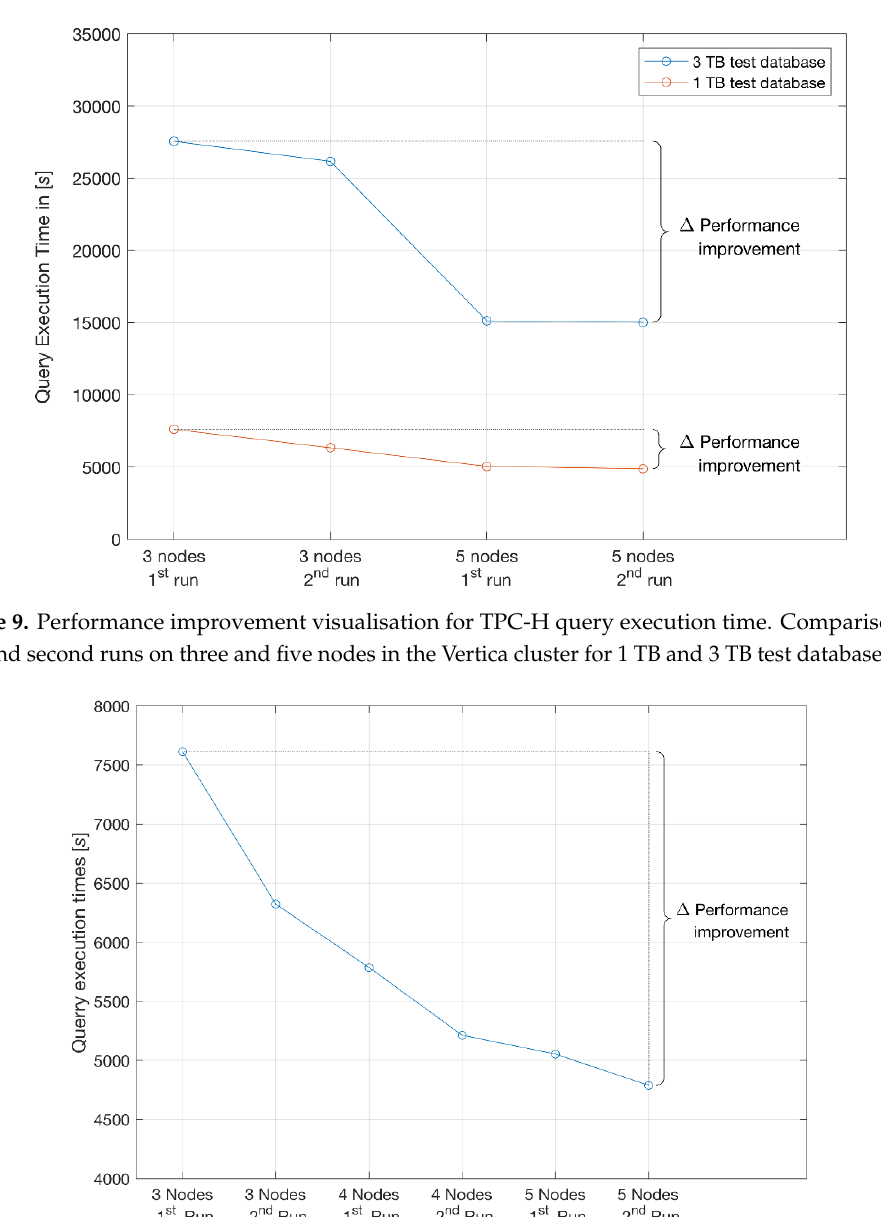
Figure 10. The total sum of the 22 TPC-H test query execution times on three to five nodes in the Vertica cluster for the 1 TB test database. Performance improvements are noticeable after the second run due to database restart only and after horizontal scaling with additional